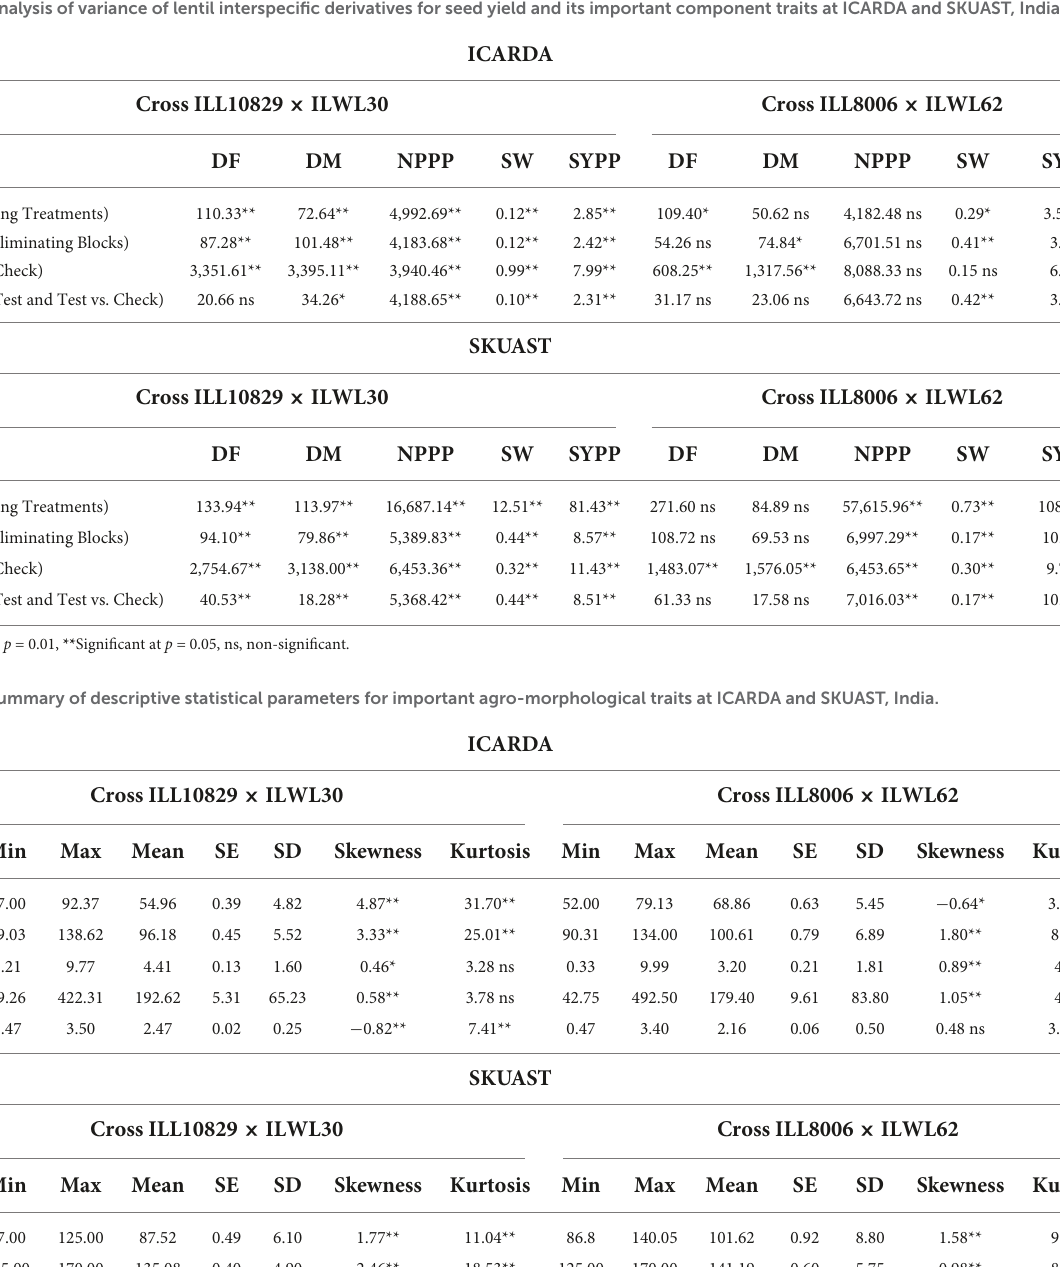
TABLE 2 Analysis of variance of lentil interspecific derivatives for seed yield and its important component traits at ICARDA and SKUAST, India.